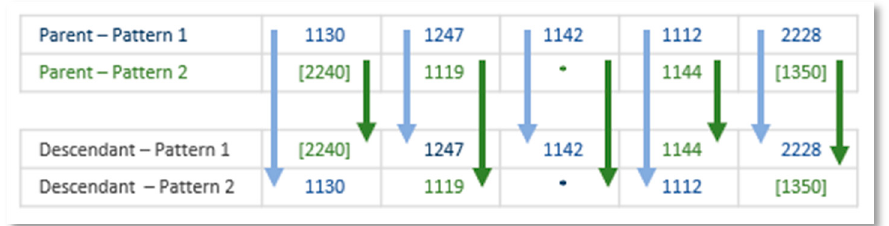
Figure 12. Sample breeding process. Asterisk represents a wildcard token as described in Section 3.1.5.